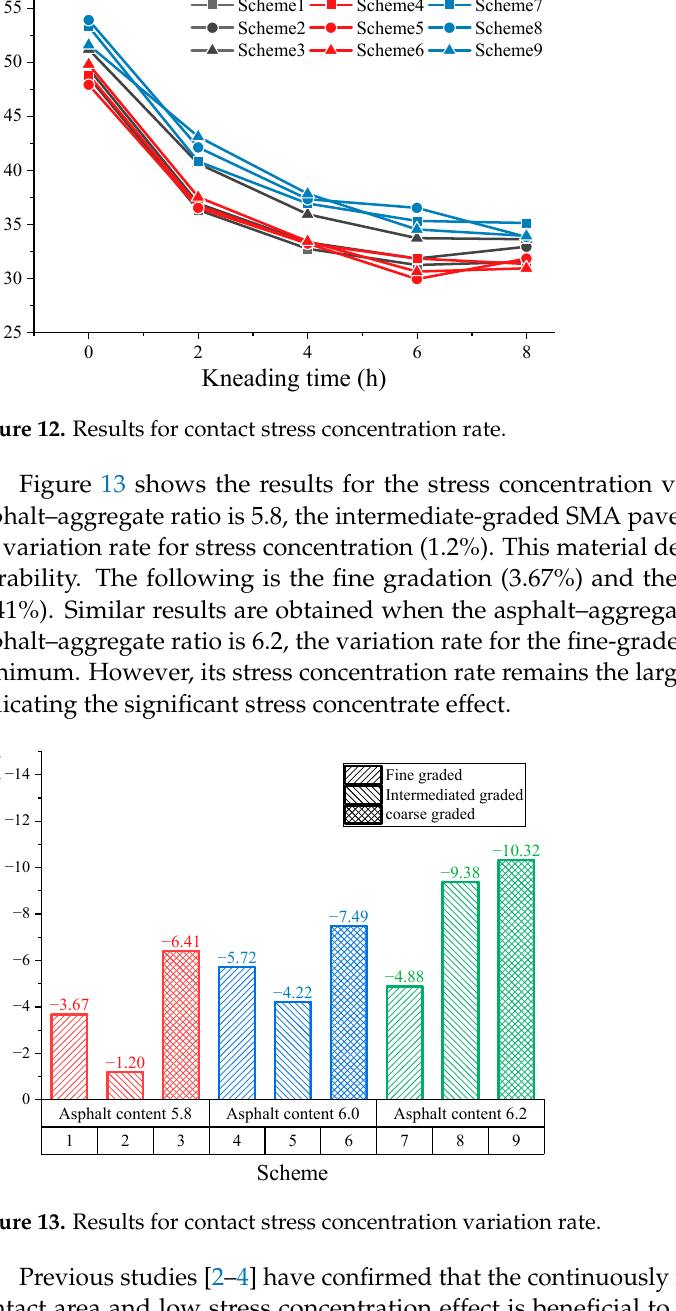
Figure 13. Results for contact stress concentration variation rate.